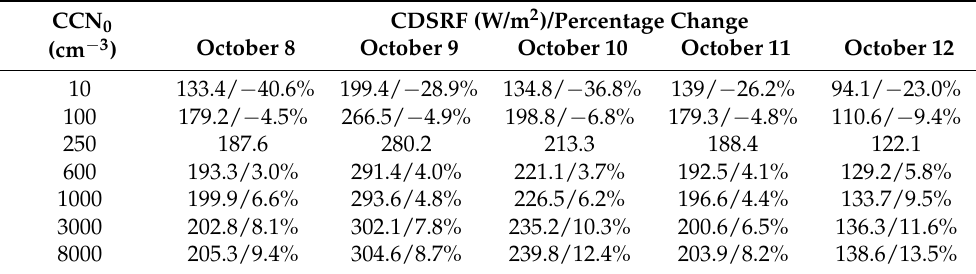
Table 4. Area-averaged CDSRF (W/m 2 ) of Region A with CCN changing and their percentage change based on that with CCN 0 set as 250 cm − 3 at 12:00 UTC from 8 to 12